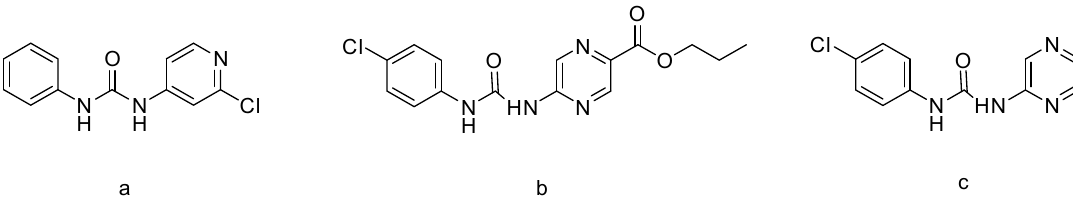
Figure 3. The chemical structure of ( a ) 1-(2-chloropyridin-4-yl)-3-phenylurea; ( b ) compound 8 ; and ( c ) compound 18.